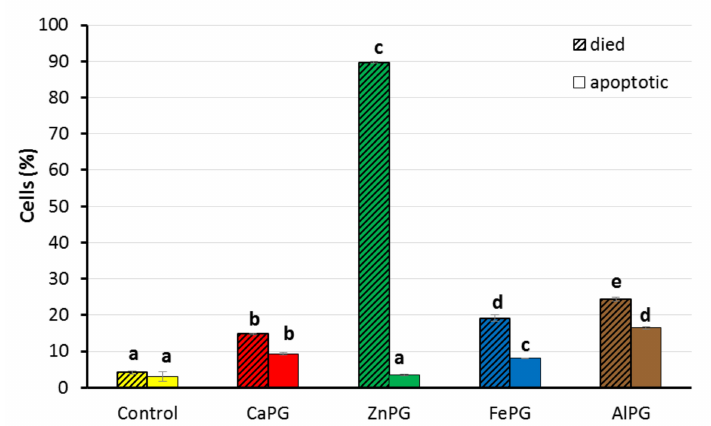
Figure 10. Effect of CaPG, ZnPG, FePG, and AlPG beads on viability of human fibroblasts. Control (cells in the presence of culture medium) corresponded to 100% viability. The bars shaded diagonally indicate the number of propidium-iodide-positive cells. Uniformly colored bars without shading indicate the number of Annexin-V-positive and propidium-iodide-negative cells Different letters indicate significant differences between pectin gel beads prepared with different cations ( p <